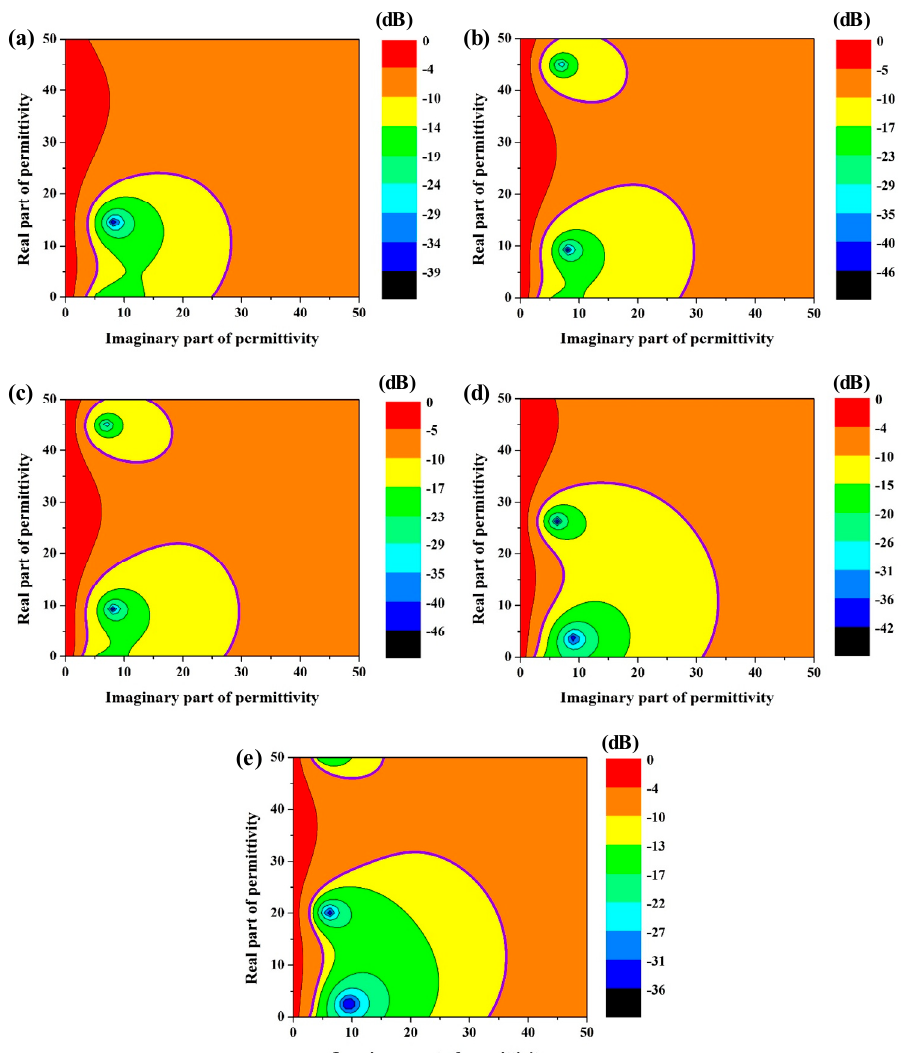
Figure 3. Reflection loss spectrums of the coated lossy material with different dielectric properties: ( a ) 8.2 GHz, ( b ) 9.2 GHz, ( c ) 10.2 GHz, ( d ) 11.2 GHz, and ( e ) 12.2 GHz.